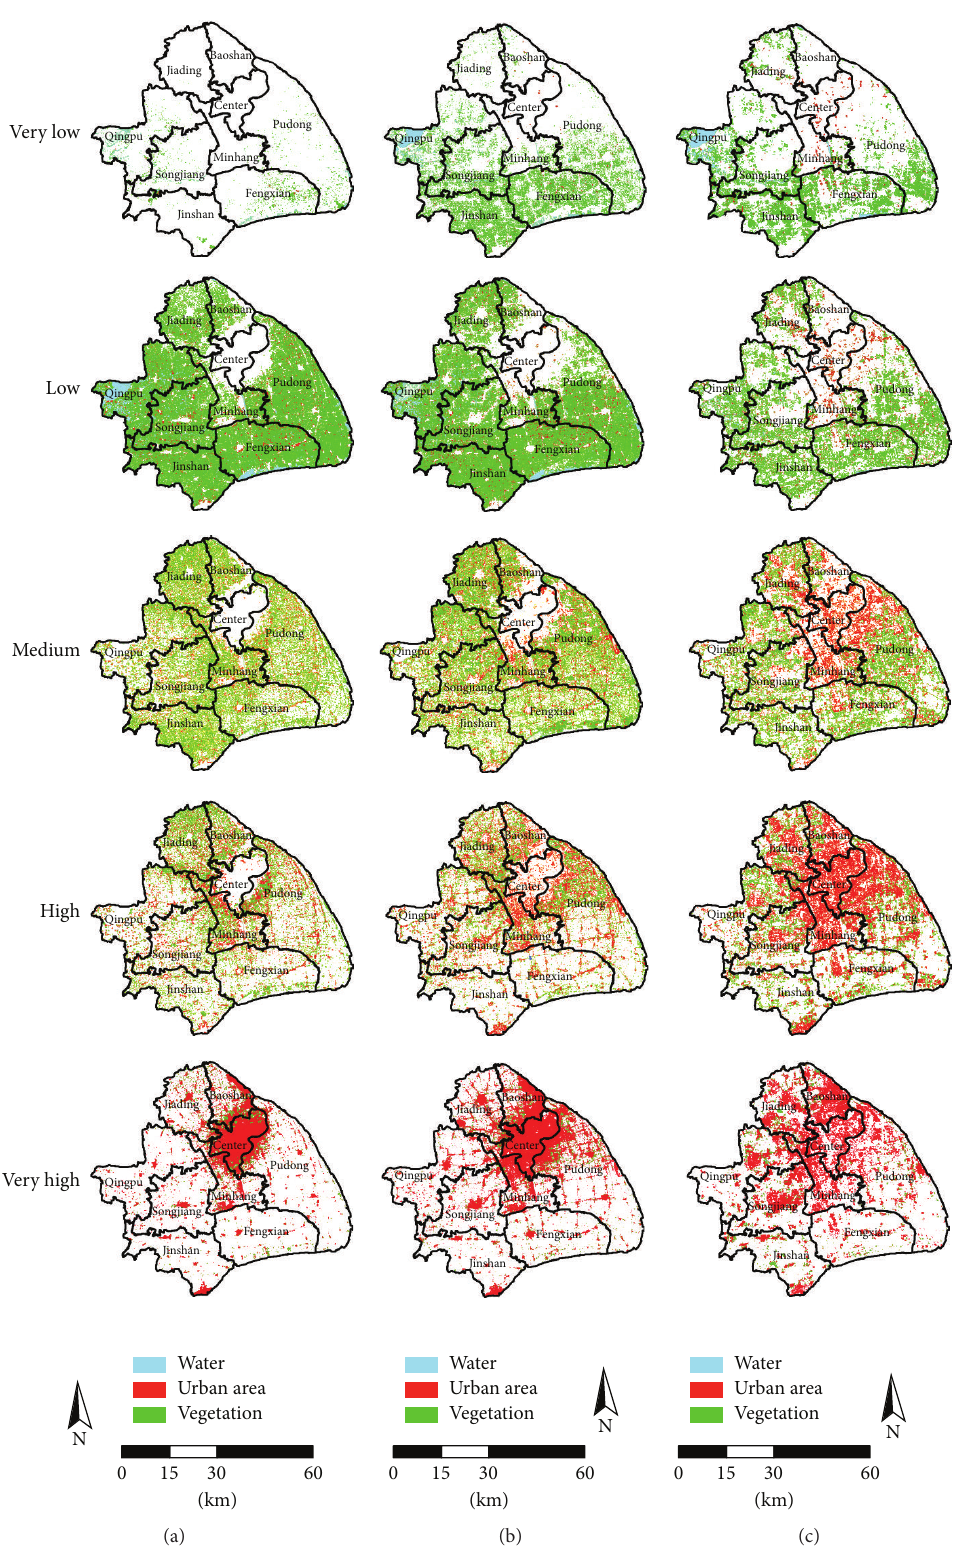
Figure 8: The land use of the 5 LST classes in Shanghai: row 1: very low, row 2: low, row 3: medium, row 4: high, and row 5: very high; (a) 1989, (b) 2000, and (c)